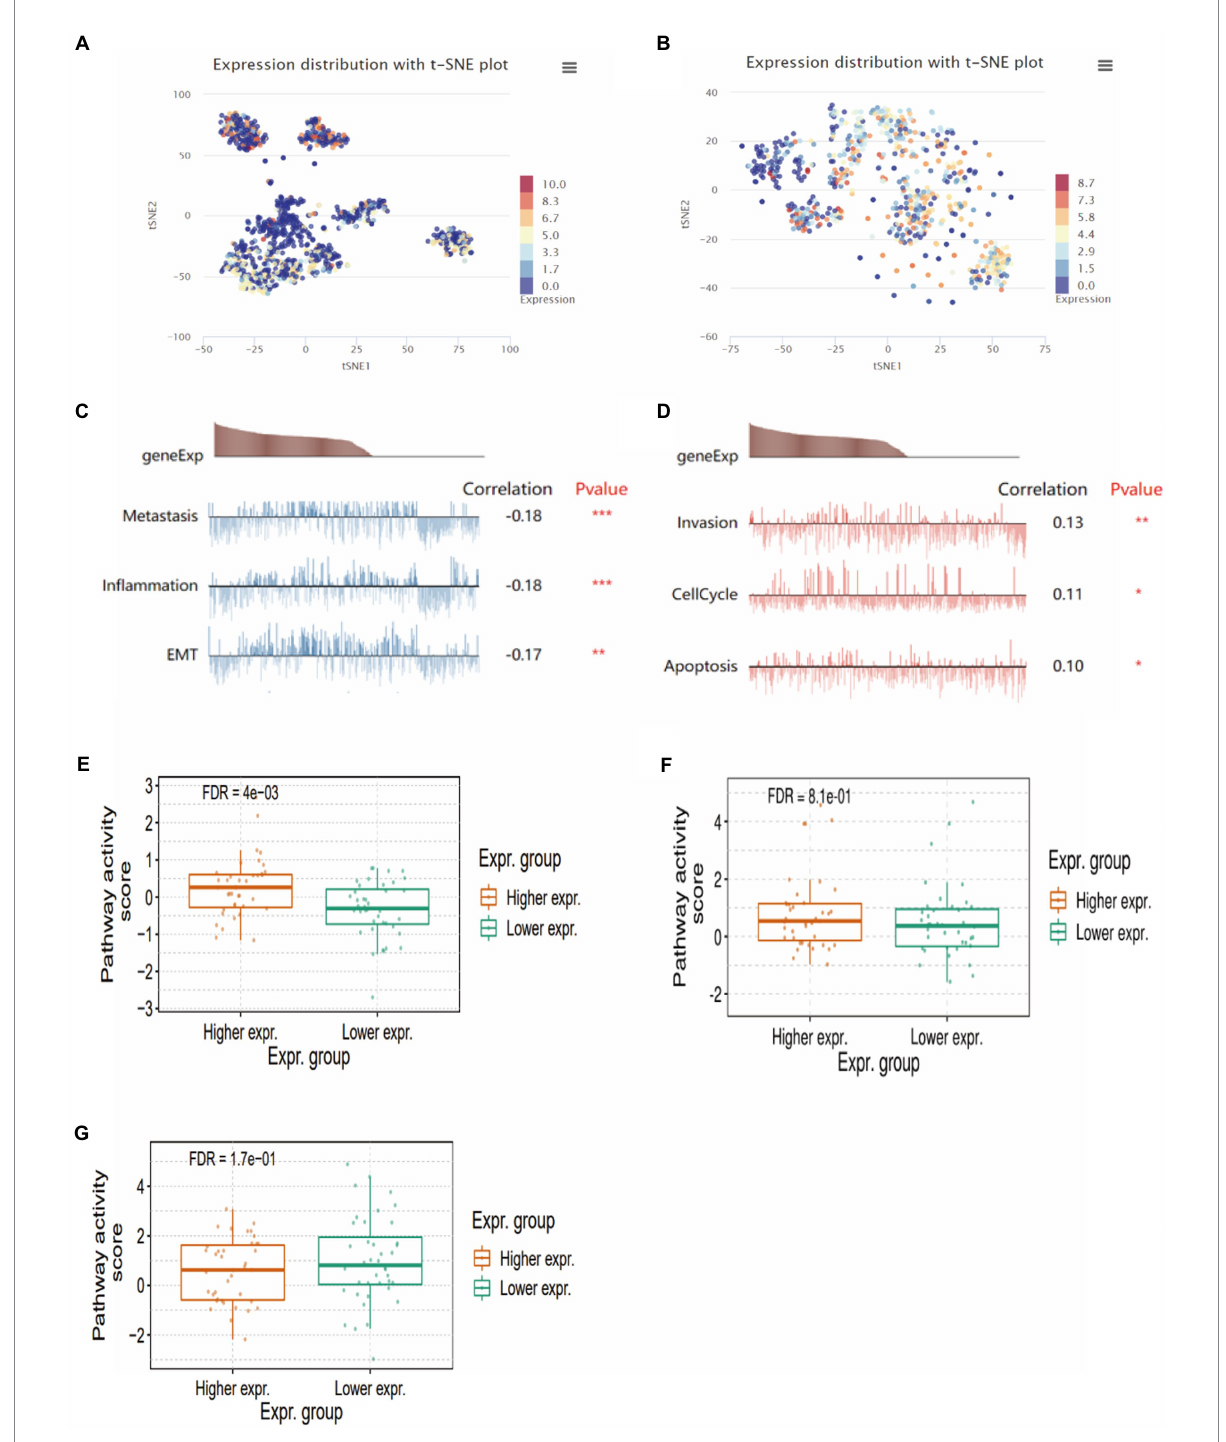
FIGURE 5 The relationship between CMTM6 and functional states. (A,B) CMTM6 expression clustering in GBM cell population (CancerSEA). (C,D) Relationship between CMTM6 expression and GMB cell function (CancerSEA). (E) The relationship between CMTM6 expression and EMT pathway activation (GSCA). (F) Relationship between CMTM6 expression and apoptosis pathway activation (GSCA). (G) Relationship between CMTM6 expression and cellcycle pathway activation